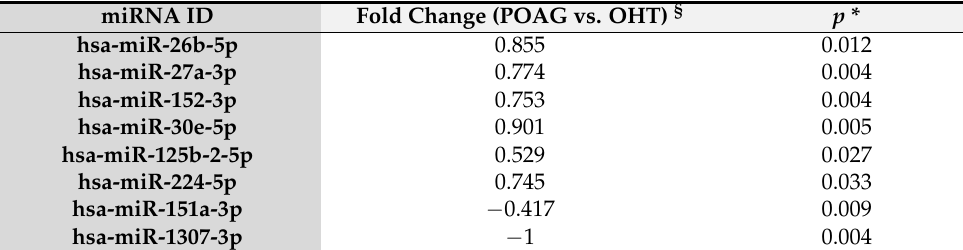
Table 4. Differences in miRNA expression between